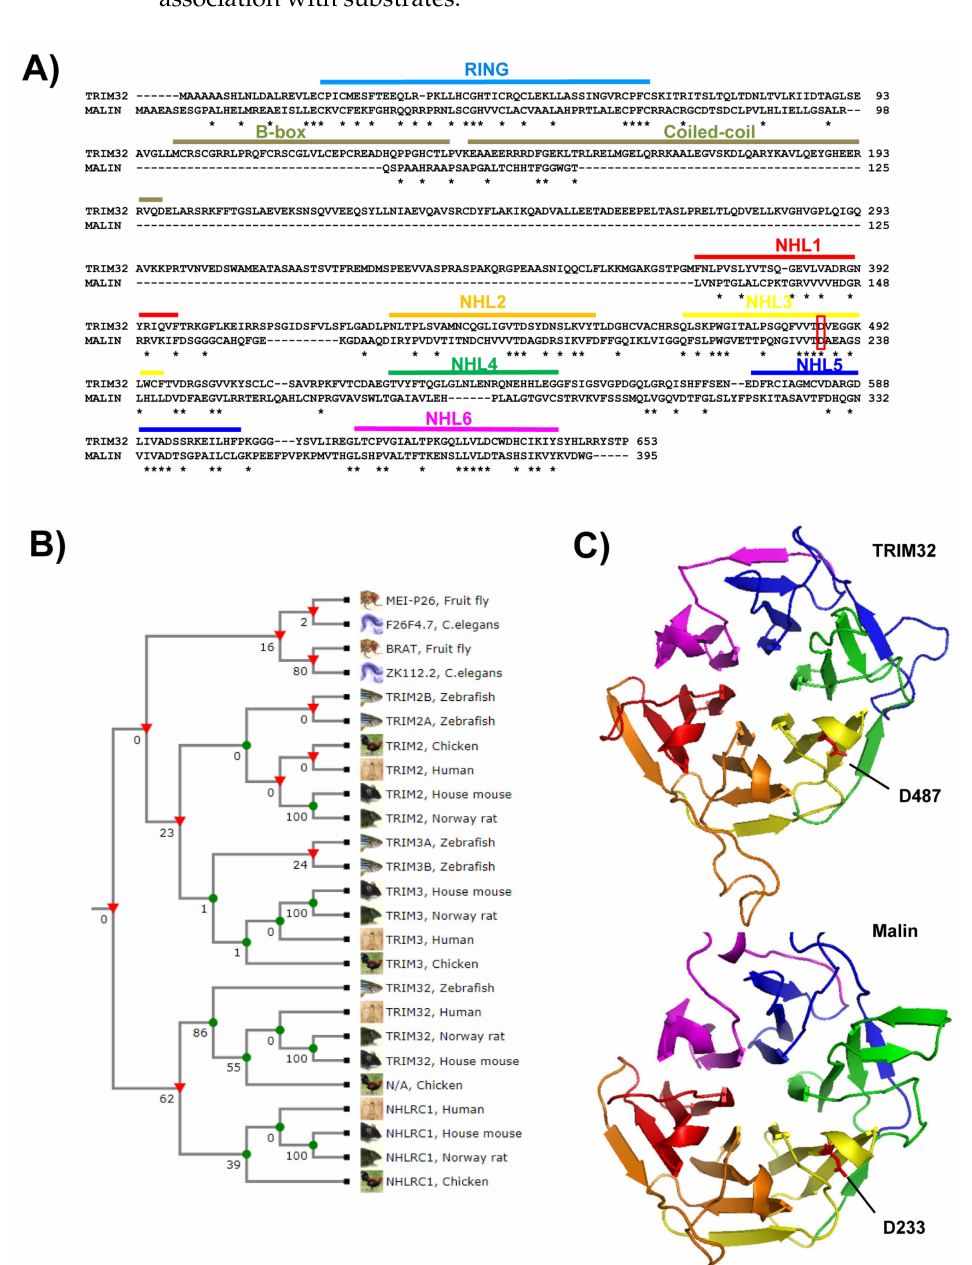
Figure 3. Structural data of TRIM32 and malin. ( A ) Protein sequence similarity between TRIM32 and malin. The position of the RING domain (in blue), the B-box and coiled-coil domains (in grey), and the six NHL domains (in red, orange, yellow, green, dark blue, and magenta) are indicated; the position of the residues D487 and D233 is also indicated in a red box; protein sequence alignment was performed using CLUSTAL-W (https://www.expasy.org/resources/clustalw, accessed on 1 January 2021). Identical amino acids are indicated with an asterisk at the bottom of the sequence. ( B ) Phylogenetic relationship between TRIM32 and malin (NHLRC1) using TreeFam from EMBL-EBI. ( C ) Modelling of the C-terminal domain of TRIM32 and malin using the Swiss-Model homology modeling software (http://swissmodel.expasy.org, accessed on 1 January 2021) and the crystal structure of the C-terminal domain of Danio rerio TRIM71 (PDB 6FPT) as a model. Disease- related residues D487 in TRIM32 and D233 in malin are located in an analogous